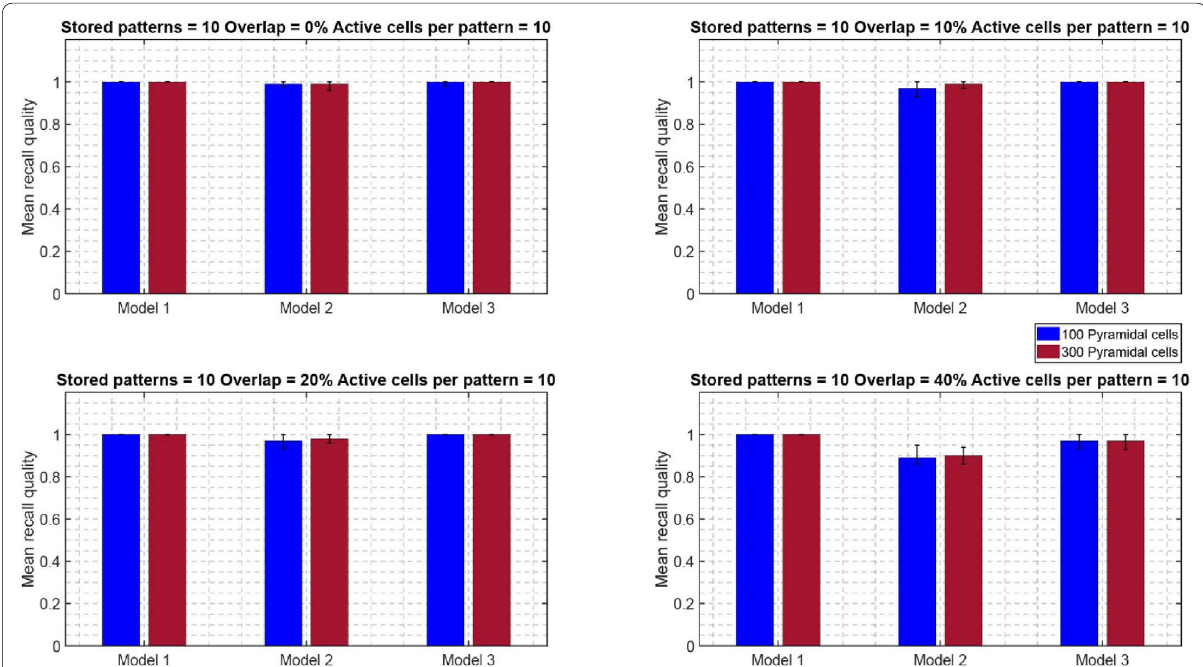
Fig. 15 Comparison of mean recall quality of ‘model 1’, ‘model 2’, and ‘model 3’ as a function of network size (100 PCs vs 300 PCs) for ten stored patterns, ten active cells, and different % pattern